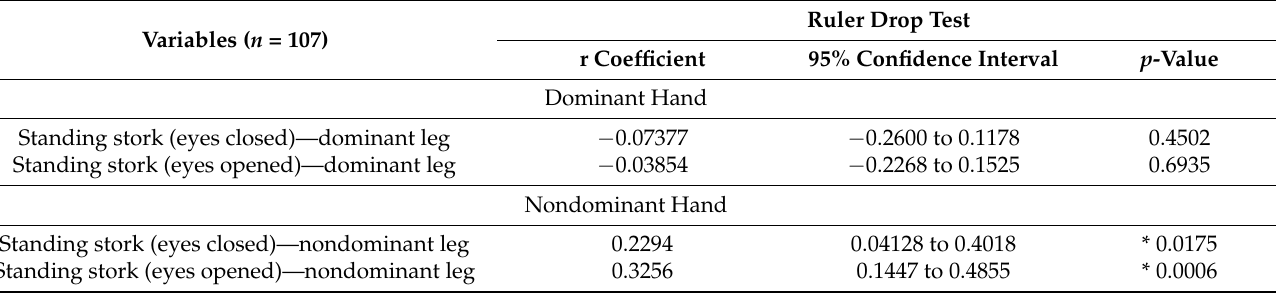
Table 4. Statistical correlation between the variation of the standing stork